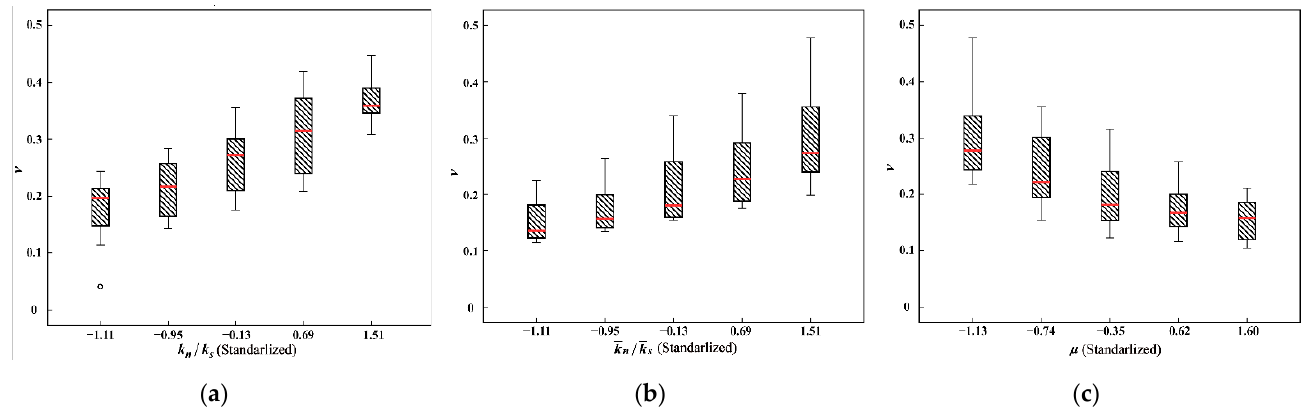
Figure 8. Boxplot between elastic modulus and meso parameters: ( a ) Equivalent modulus and parallel bond equivalent modulus; ( b ) Parallel bond stiffness ratio; ( c ) Control gap of parallel bond.